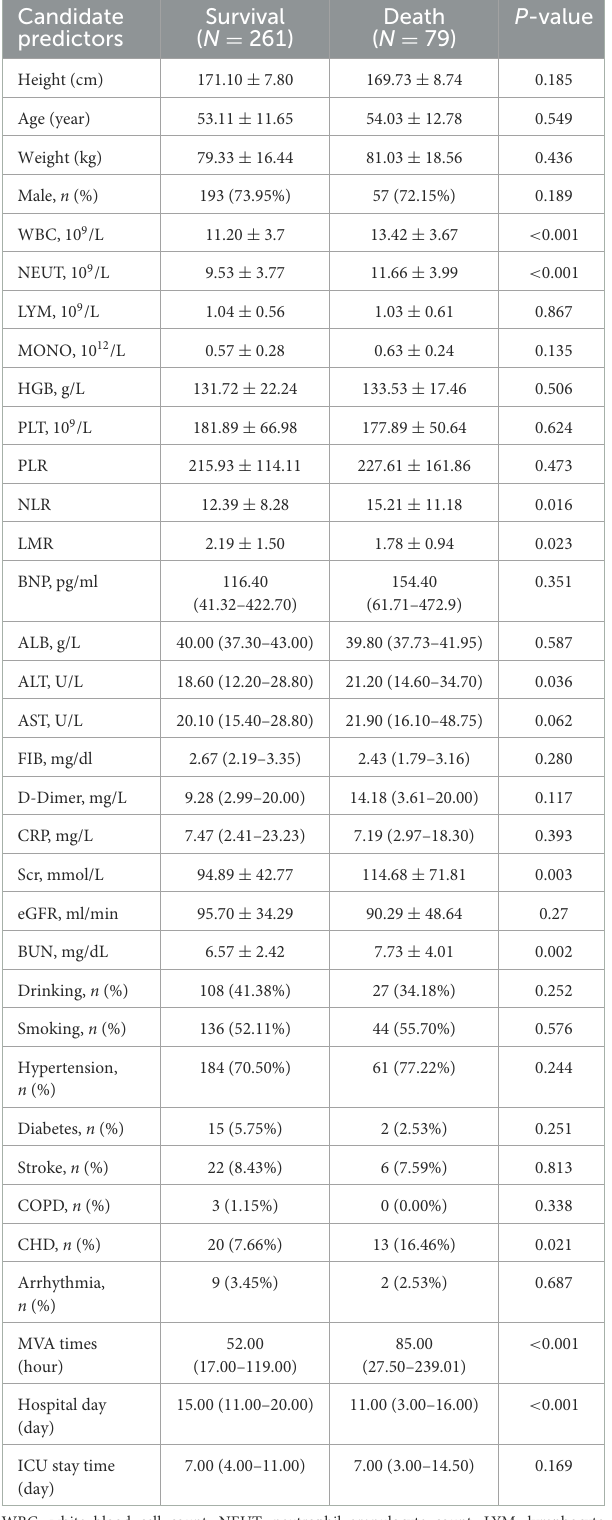
TABLE 1 Candidate predictors of 340 patients with ATAAD in the derivation